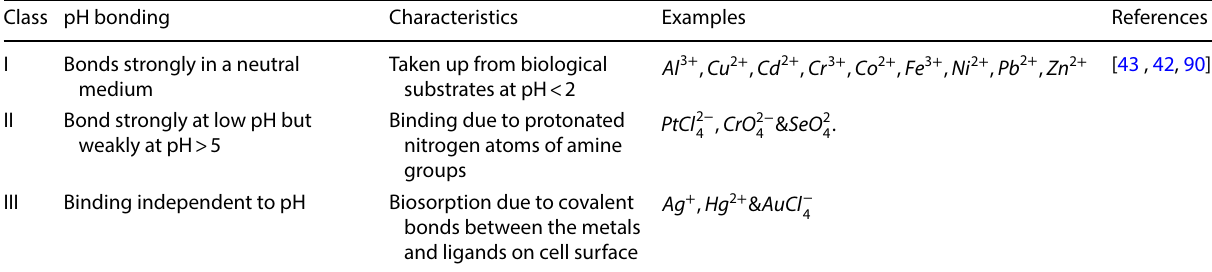
Table 6 Classes of metal species and their pH biosorption